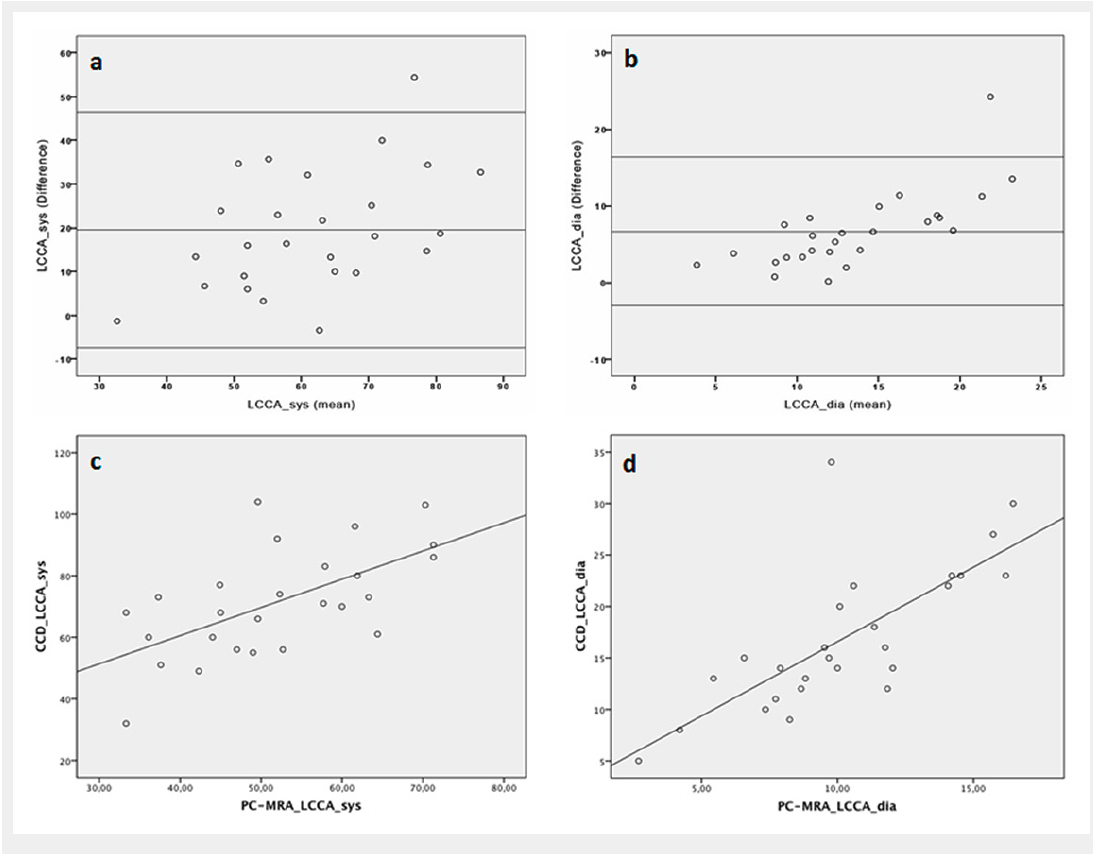
Figure 3 Bland-Altman analysis of colour-coded duplex (CCD) sonography compared with phase contrast magnetic resonance angiography (PC-MRA) of the left common carotid artery (LCCA) showed 25 of 26 points within 1.96 standard deviations for peak systolic velocity (PSV) (a) with a bias of 19.55 and 1.96 SD limits of agreement of –7.44 and 46.54 and for end diastolic velocity (EDV) (b) with a bias of 6.68 and 1.96 SD limits of agreement of –3.00 and 16.36. The Spearman’s r for PSV was 0.598 (c) and for EDV was 0.777 (d), both significant at the 5%